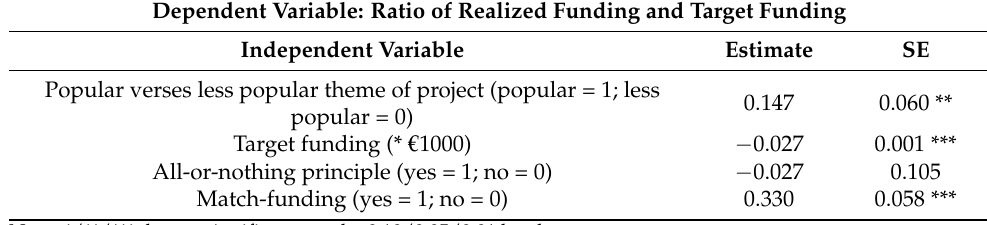
Table 2. Results of mixed regression model with campaign characteristics as independent variables. Dependent Variable: Ratio of Realized Funding and Target Funding Independent Variable